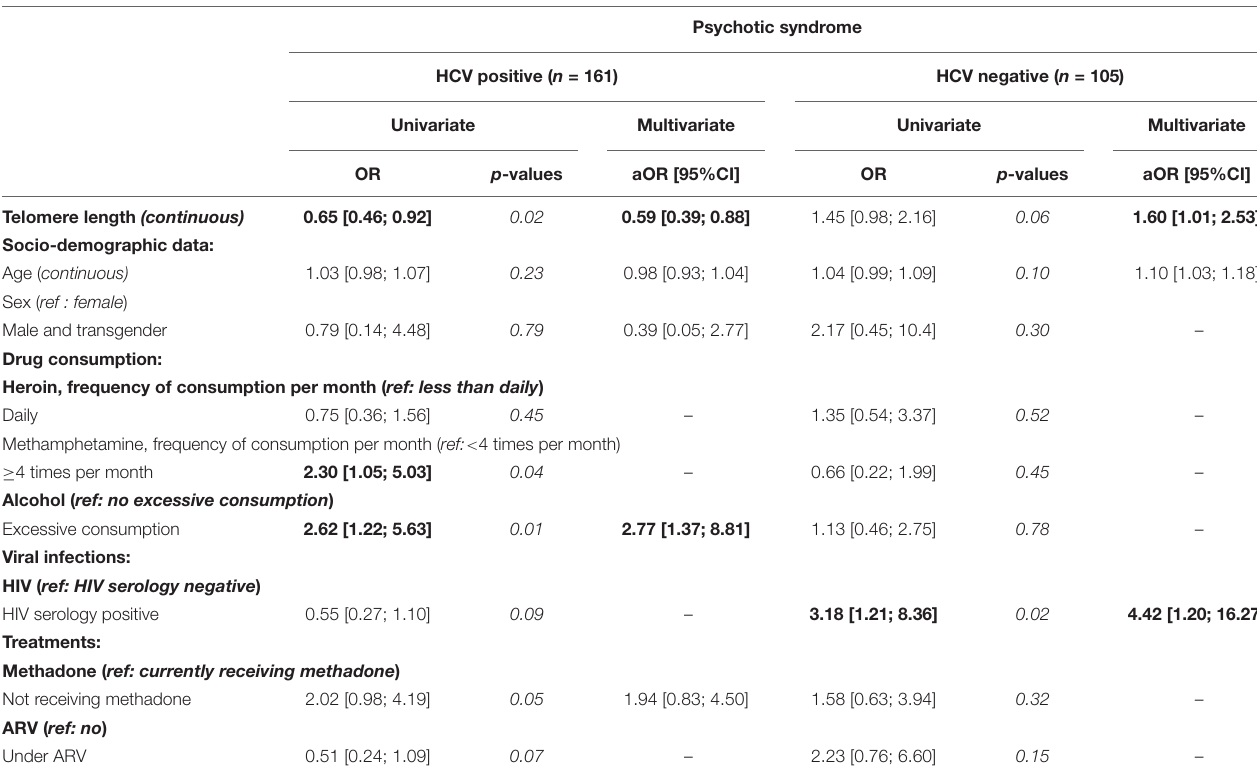
TABLE 6 | Determinants of “having a psychotic syndrome” among PWID. Psychotic syndrome HCV positive ( n = 161) HCV negative ( n = 105) Univariate Multivariate